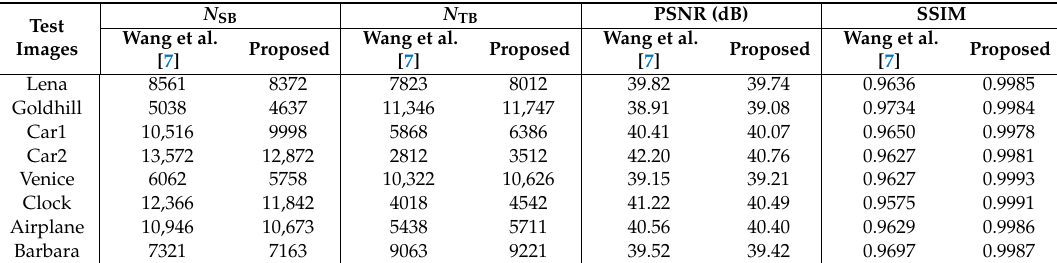
Table 1. Comparison of watermark embedding results along four